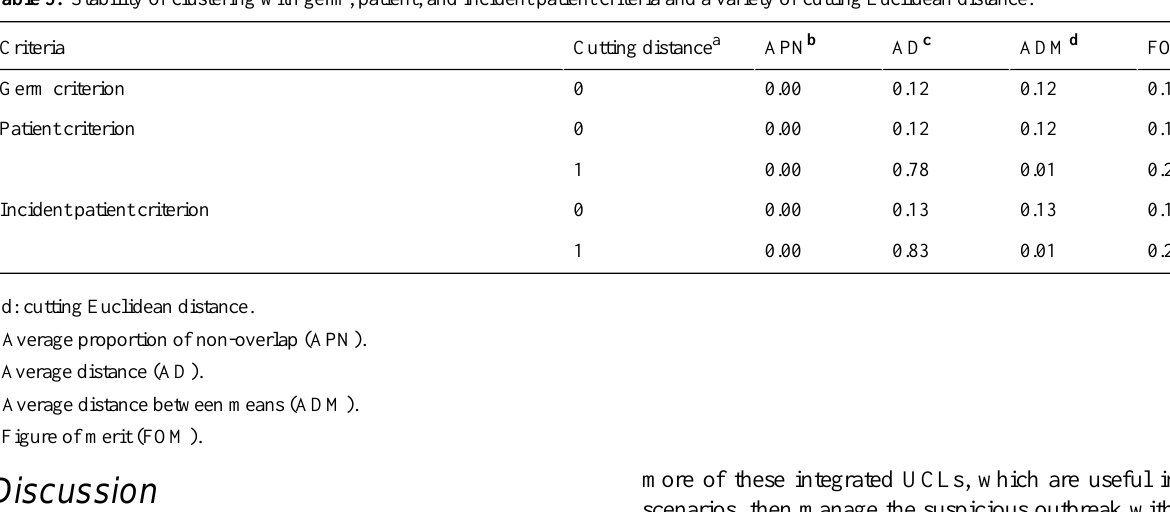
Table 5. Stability of clustering with germ, patient, and incident patient criteria and a variety of cutting Euclidean